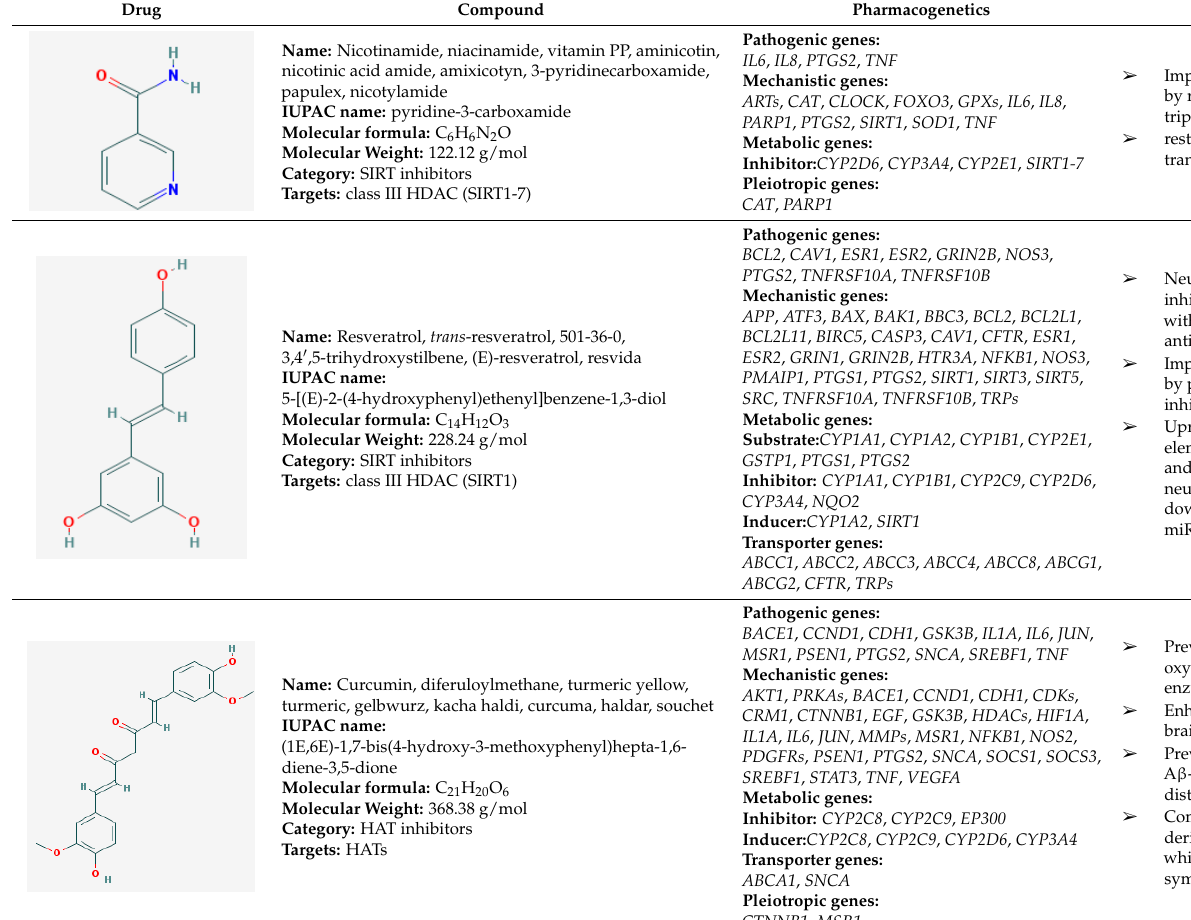
Category: HAT inhibitors Targets: HATs